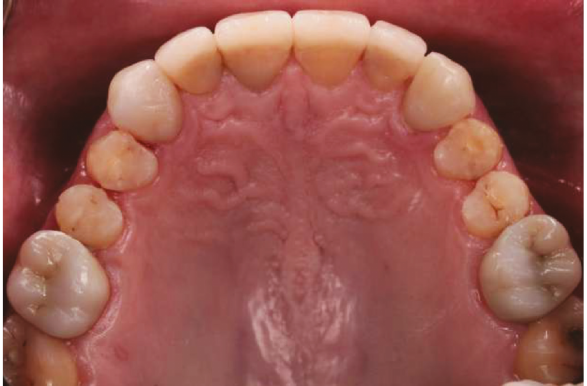
Figure 8: Digital scan.